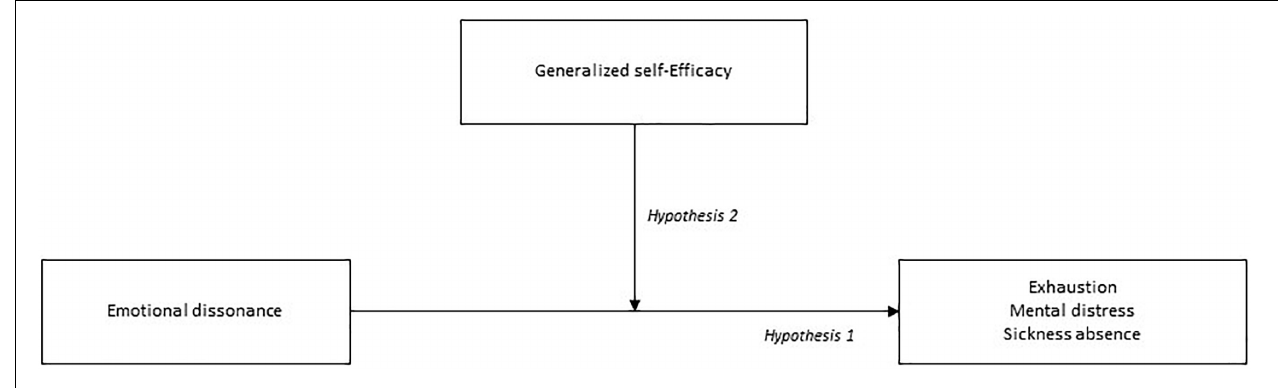
FIGURE 1 | A graphical conceptual overview of the described moderated associations.